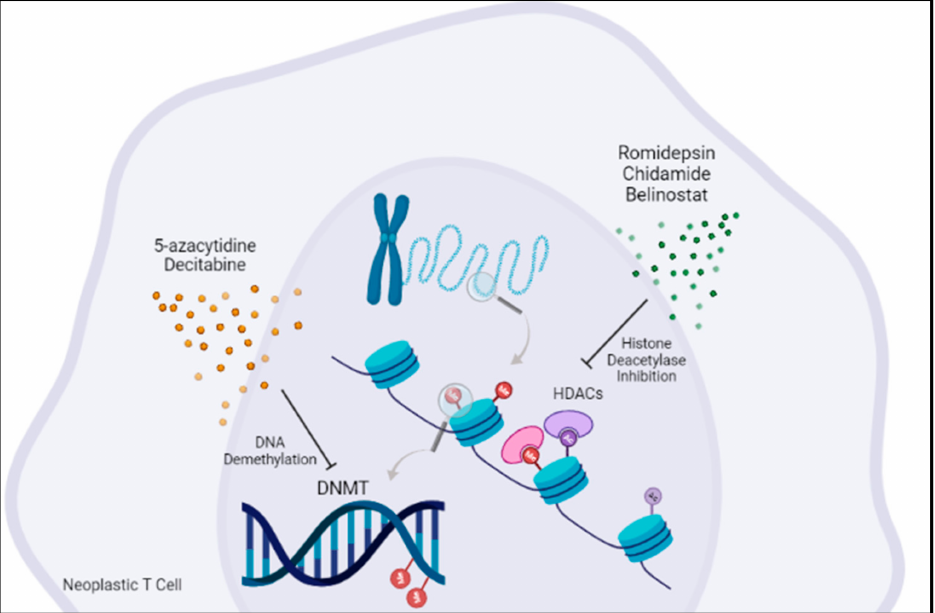
Figure 1. Epigenetic regulators can be targeted via several inhibitors in AITL treatment. DNMT: DNA methyltransferase; HDACs: Histone